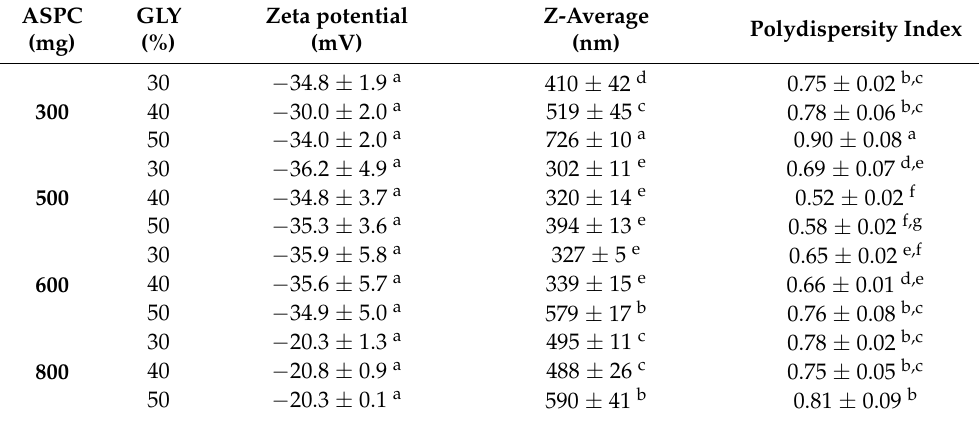
Table 1. Zeta potential, Z-average, and polydispersity index values of film-forming solutions con- taining increasing amounts of argan seed protein concentrate (ASPC) and glycerol (GLY). Different small letters (a–g) indicate significant differences among the values reported in each column ( p < 0.05). Further experimental details are given in the text.